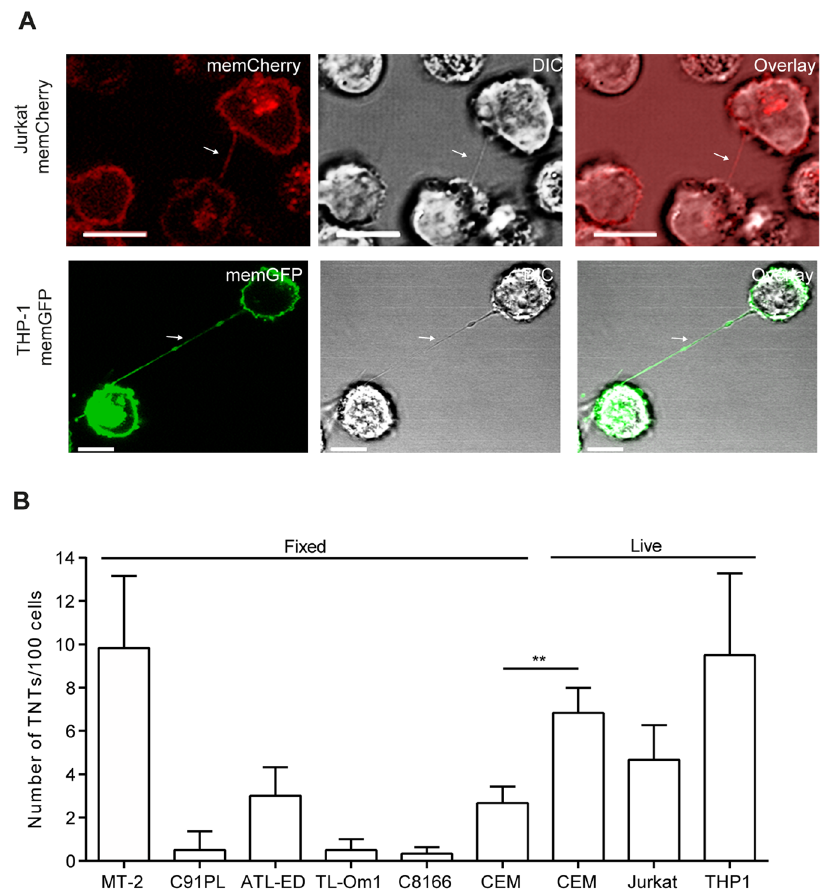
Figure 2. TNTs in HTLV-1 positive and negative cells. ( A ) Jurkat-memGFP (green) and THP-1-memCherry (red) cells analyzed by confocal microscopy. Arrows indicate TNTs. The images are representatives of three independent experiments. ( B ) TNTs were quantified in HTLV-1 transformed cells (MT-2, C91PL, ATL-ED, TL- Om-1 and C8166) and in HTLV-1-negative cell lines; T-cells (CEM and Jurkat) and monocytes (THP-1). TNT quantifications in HTLV-1-negative cells were performed by live cell microscopy where the Jurkat-memCherry and THP-1-memGFP cells were directly imaged while CEM cells were stained with WGA-488 prior to imaging. All HTLV-1 transformed cells were fixed and stained with WGA-488 before analyzed by microscopy. For the TNT quantification, 100 cells were counted in duplicate wells for the presence of TNTs connecting two cells as described earlier 49 . Results represent three independent experiments performed in duplicates and error bars mean ± SD. Unpaired t-test was performed to evaluate statistical significance. F-test was performed for individual variation. GraphPad Prism (Version 6.03) was used ( ** p < 0.01). Scale bars 10 µ m. Adobe photoshop CS6 was used to prepare the images. The contrast was enhanced on the whole image to better represent and visualize the thin TNT